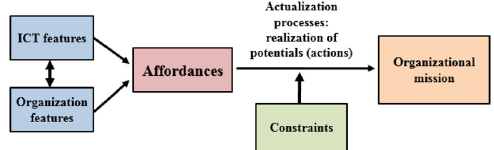
Figure 1. Process of actualizing affordances of technology for nonpro fi t